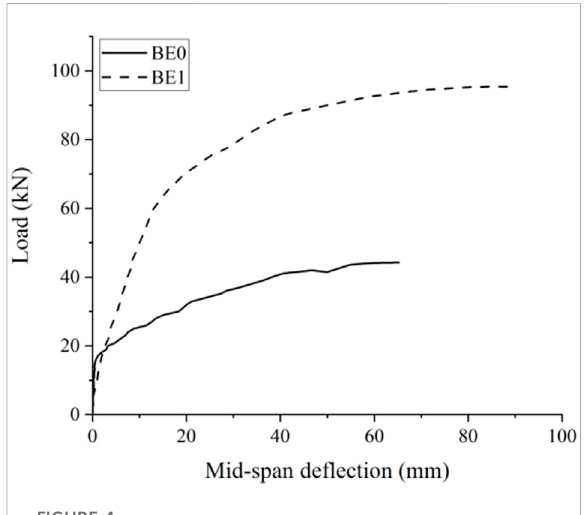
FIGURE 4 Load-displacement curves of the two specimens at midspan.